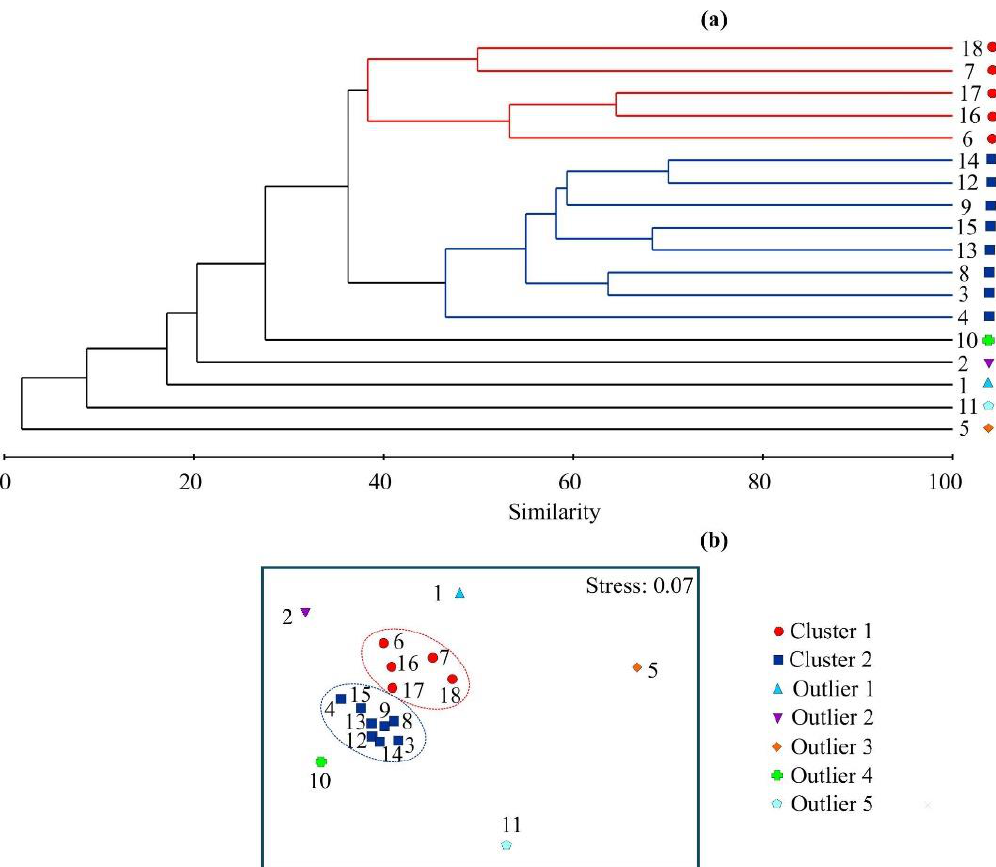
Figure 5. Dendrogram resulting from clustering ( a ), and a 2D nMDS plot ( b ) summarizing the similarity of bryozoan fauna in Grønfjorden performed on the Bray–Curtis similarity matrix produced from fourth-root-transformed biomass data.